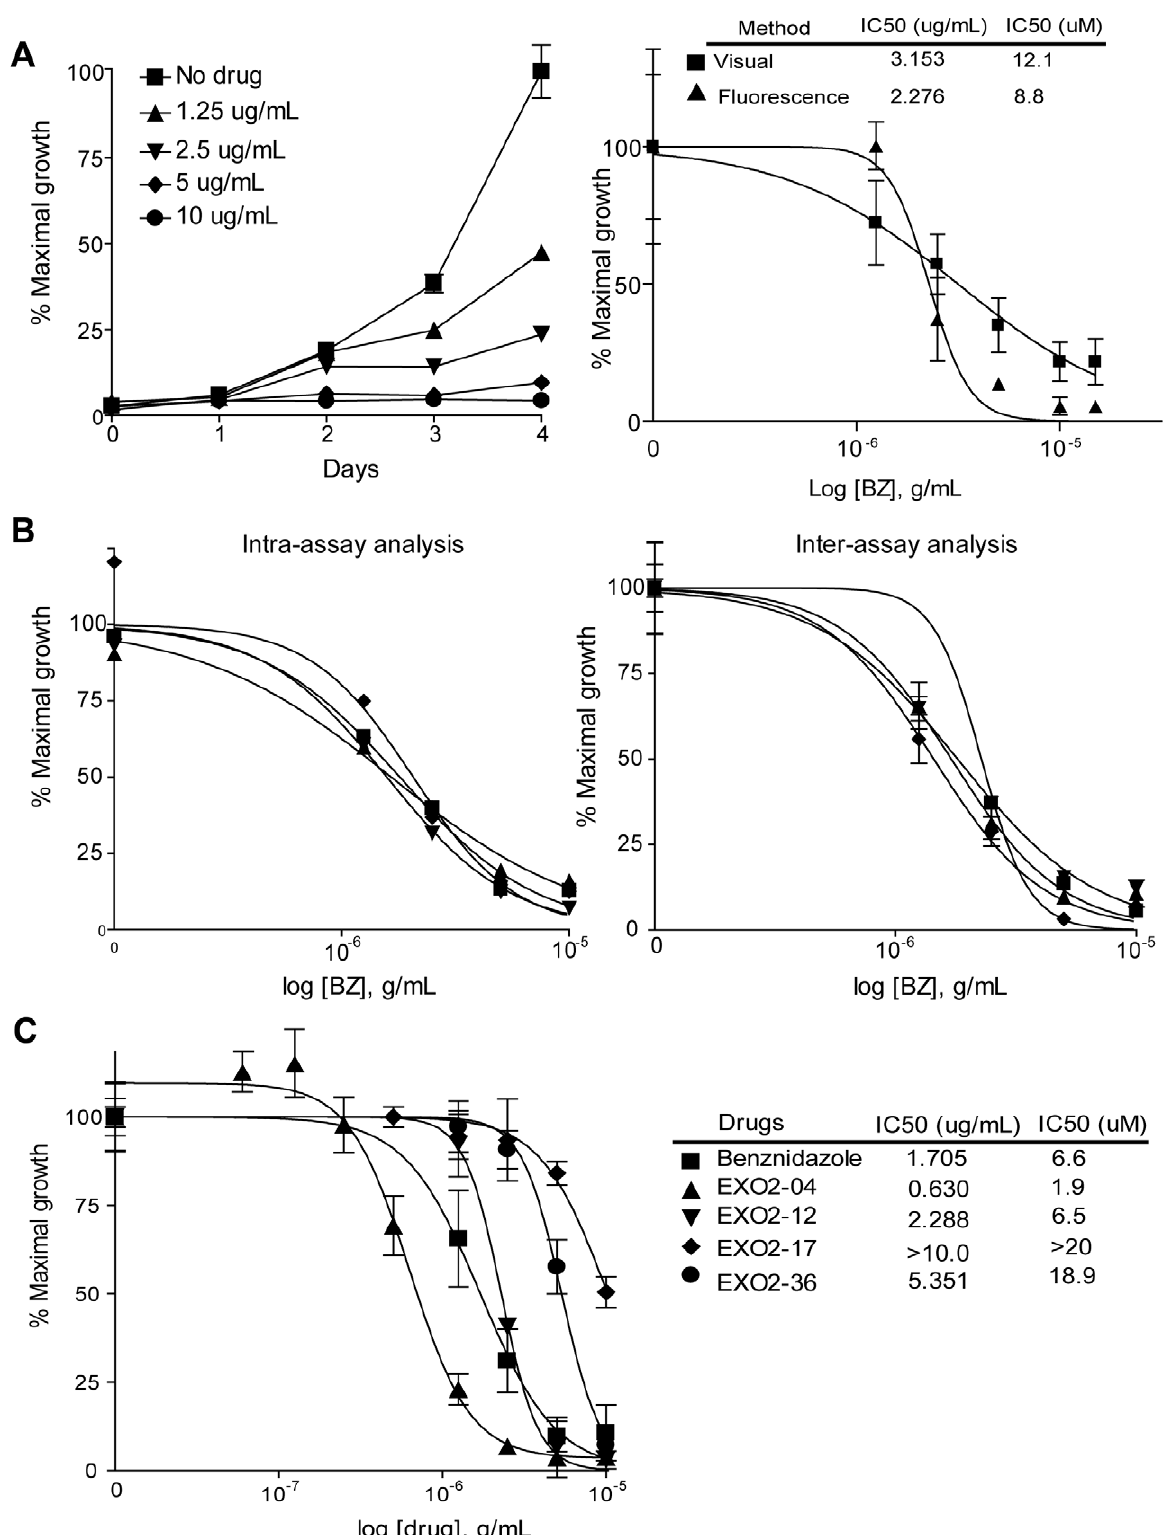
Figure 3. In vitro epimastigote growth assays using tdTomato parasites. (A) Epimastigotes growth over time in the presence of benznidazole at the indicated concentrations and comparison of measurement of drug inhibition of epimastigote growth by fluorescence and visual counting by hemacytometer. (B) Intra-assay analysis (left) showing the low variation among wells with the same drug concentration (n=4). Inter- assay analysis (right) showing the low variation among IC 50 curves from individual assays. (C) IC 50 calculation in response to benznidazole and the EXO2 derivatives activity against epimastigotes after 3 days of treatment/culture.